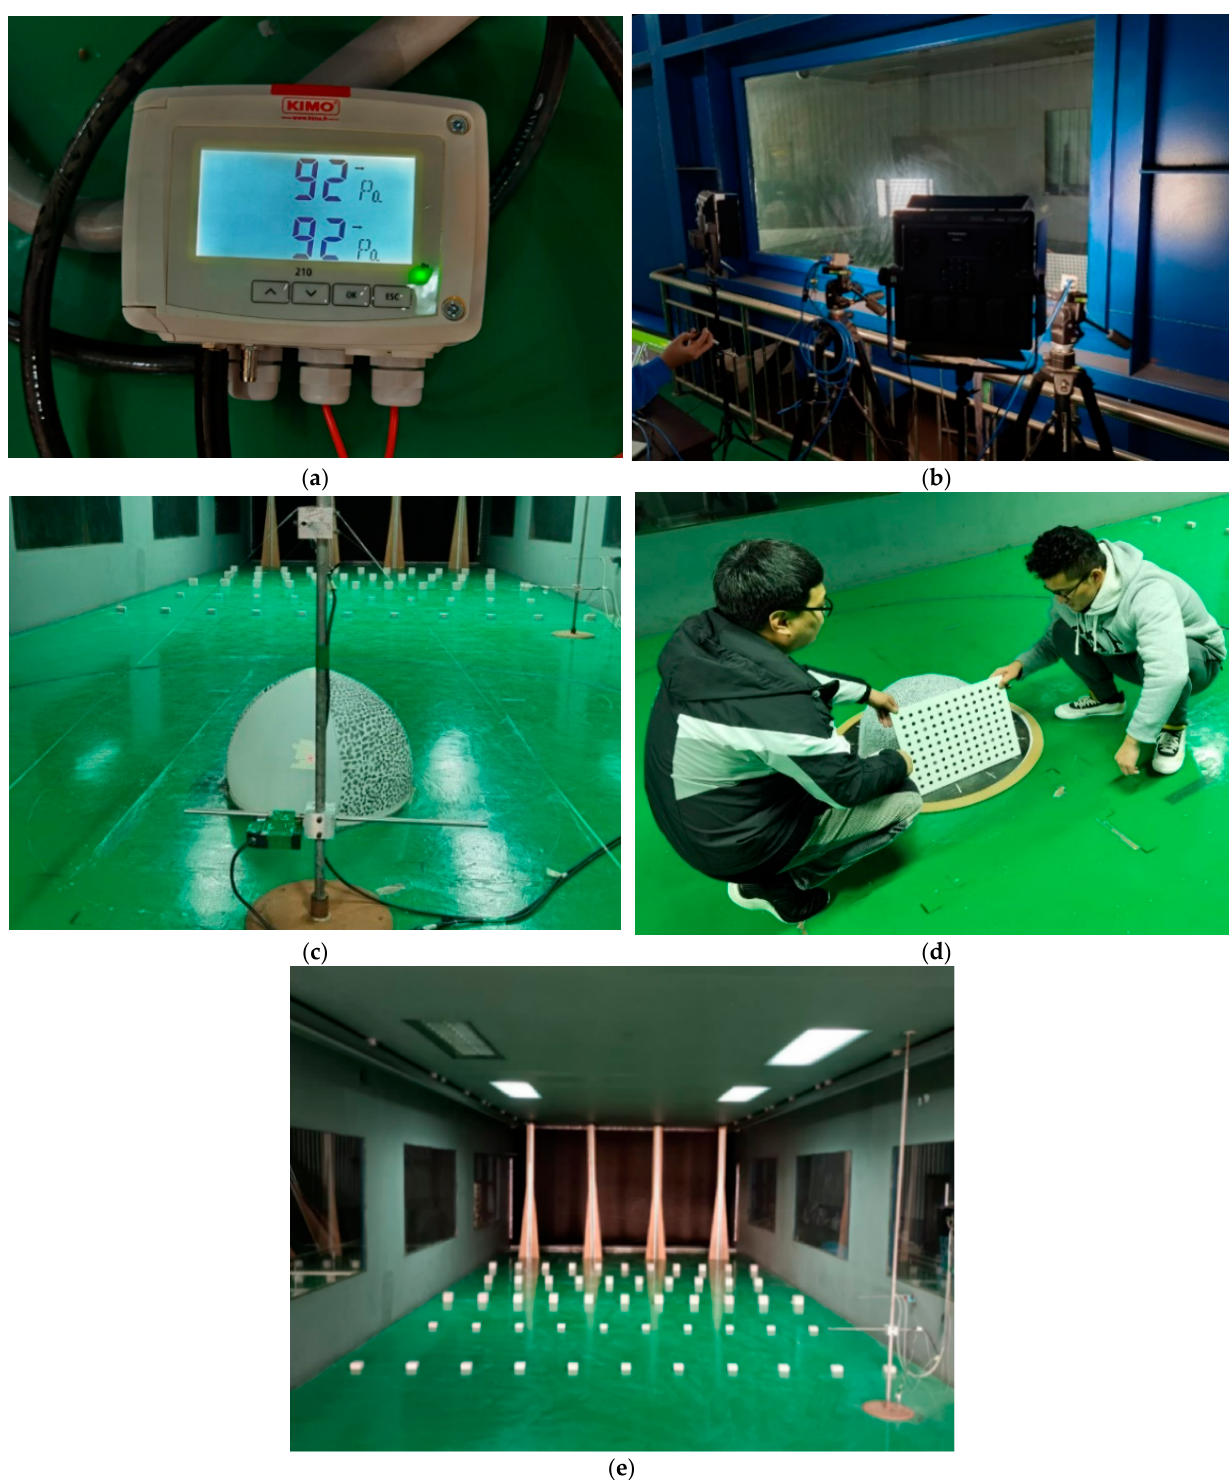
Figure 3. Experiment with key pictures: ( a ) internal pressure gauge, ( b ) stereo cameras, ( c ) aeroelastic model, ( d ) camera calibration, and ( e ) terrain B wind field simulation in the wind tunnel. The stereo cameras are a Stereo-3D measurement system from Matchid, Belgium, and the camera lens is a Japanese Kombiata FA M2518-MPW2 25 mm focal length industrial lens. It can capture 30 frames per second and captures 10 s at each wind speed. The camera is mounted outside the glass window of the wind tunnel laboratory (Figure